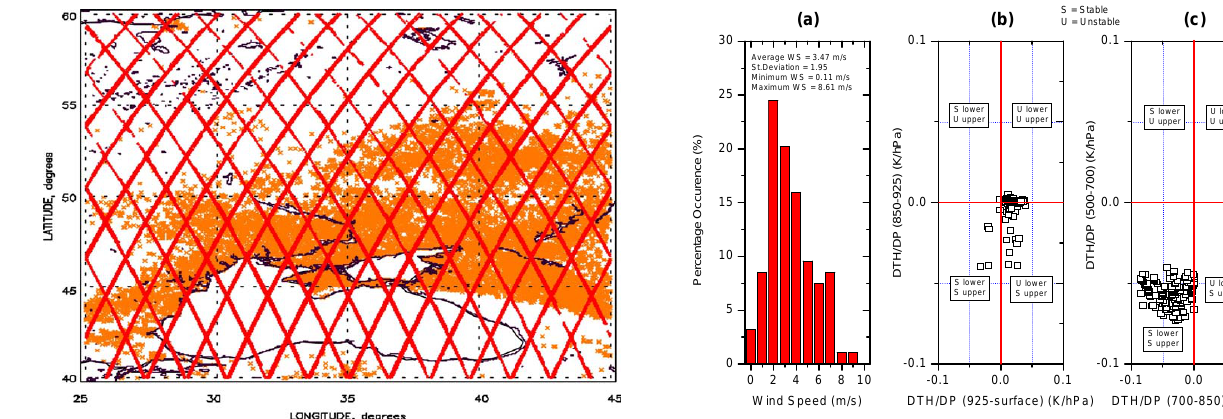
at 10m above surface for the times and locations of fires under study over the Western Russian and Eastern Europe during July and Au- gust 2006, 2007, 2008. (b) Static stability of the layer 850–925hPa, with the use of the ECMWF derived vertical gradient ∂θ / ∂p (where θ is the potential temperature and p the pressure), versus the one of the lowest layer 925-surface, during the fire cases. (c) Static sta- bility of the layer 500-700hPa, with the use of the ECMWF de- rived vertical gradient ∂θ / ∂p , versus the one of the lowest layer 700–850hPa, during the fire